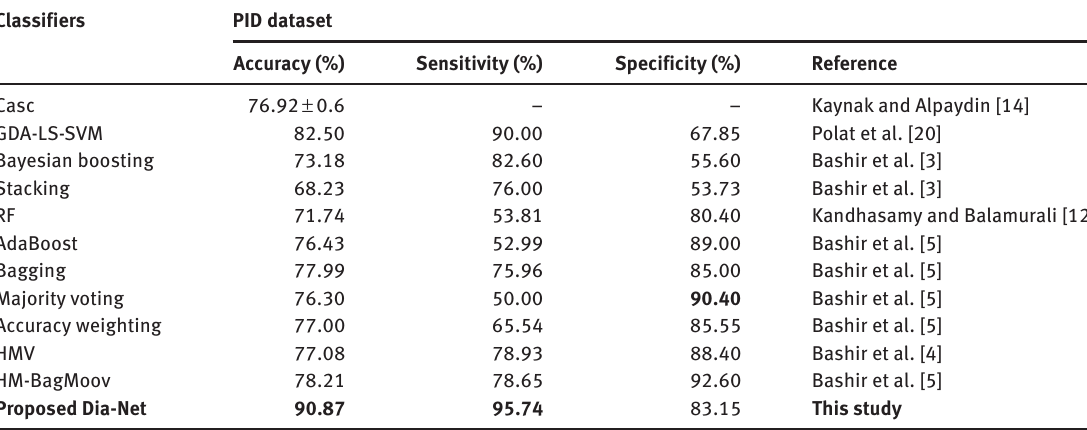
Table 7: Comparison of proposed method with other ensemble